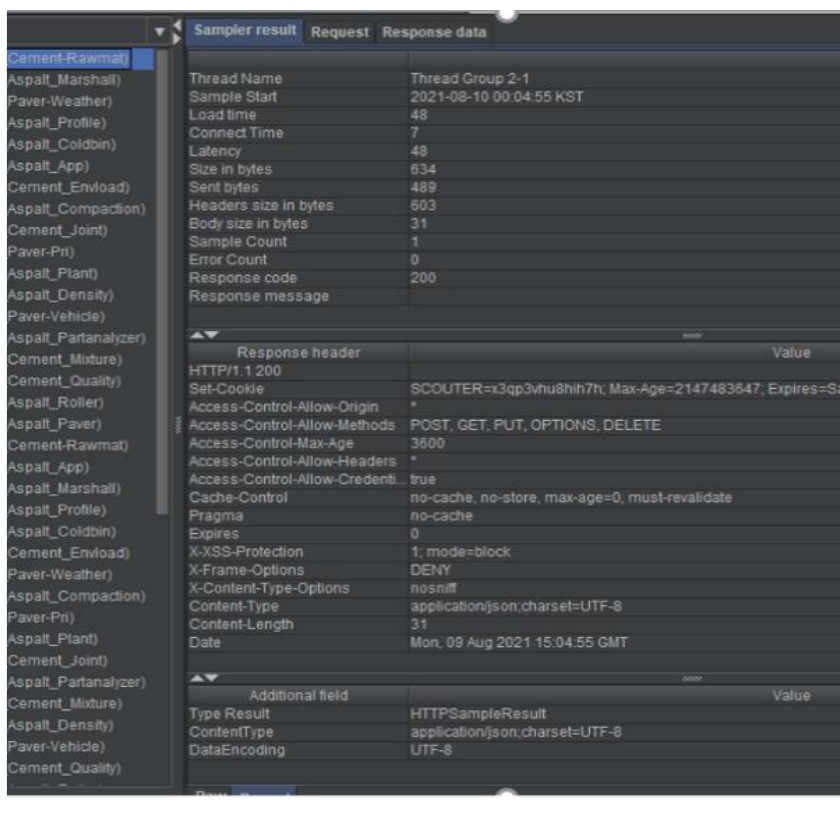
Figure 6. Interface API implementation.